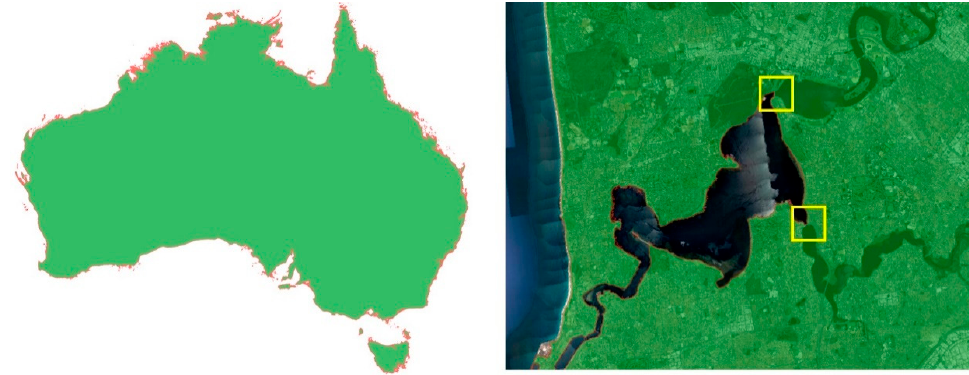
Figure A4. Ocean mask used to remove ocean and ocean-connected waterbodies from the final product. The mask incorrectly fails to map some complete estuaries where the water signal from the ocean is not continuous, like seen above in Perth, Western Australia, where two large bridges have terminated the ocean mask prematurely (yellow squares).